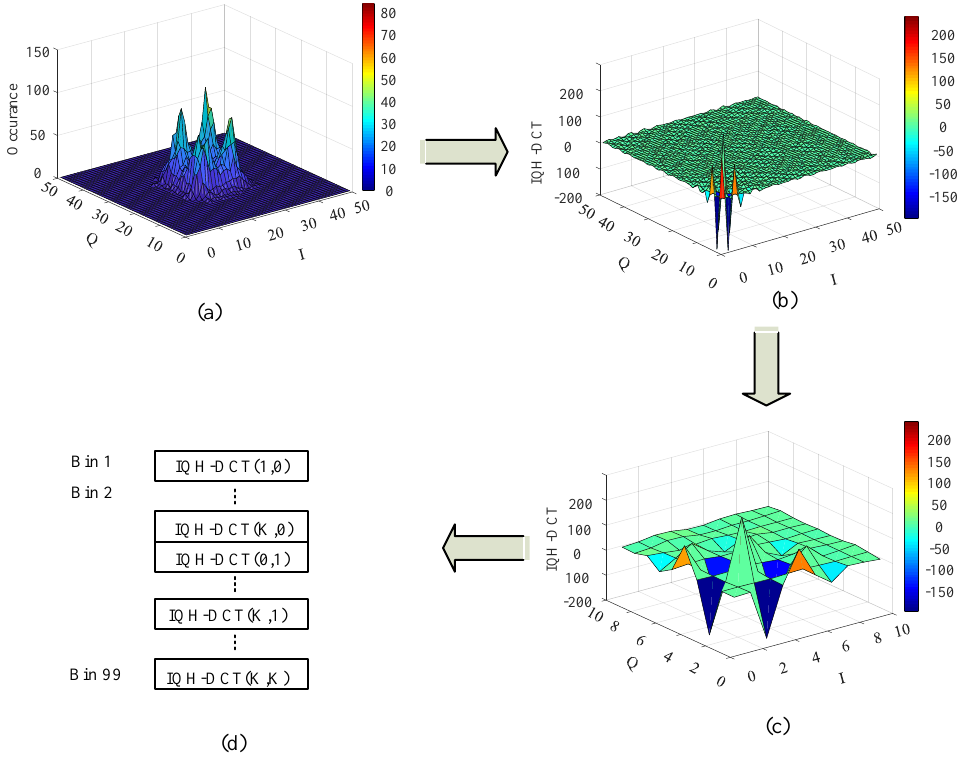
Figure 6. The concept of generating the 1D features vector, V-DCT, from the IQH of the QPSK signal. ( a ) IQH features, ( b ) IQH-DCT features, ( c ) Truncated IQH-DCT, ( d ) V-DCT